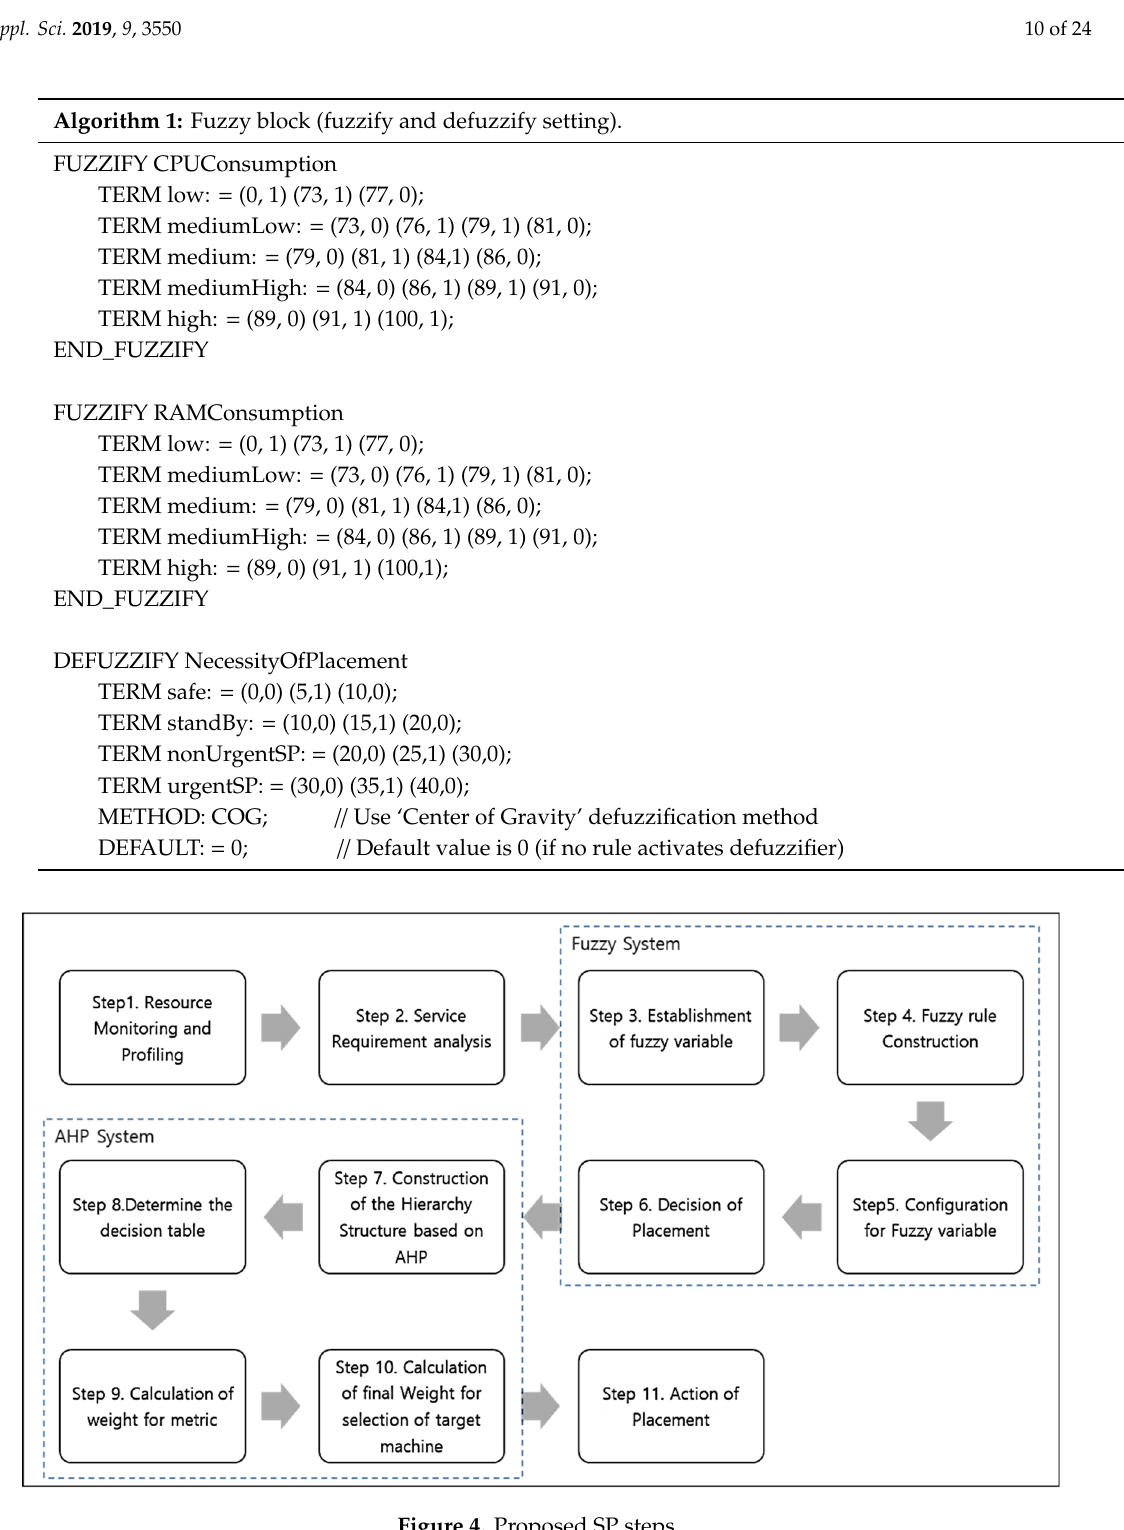
Figure 4. Proposed SP steps.